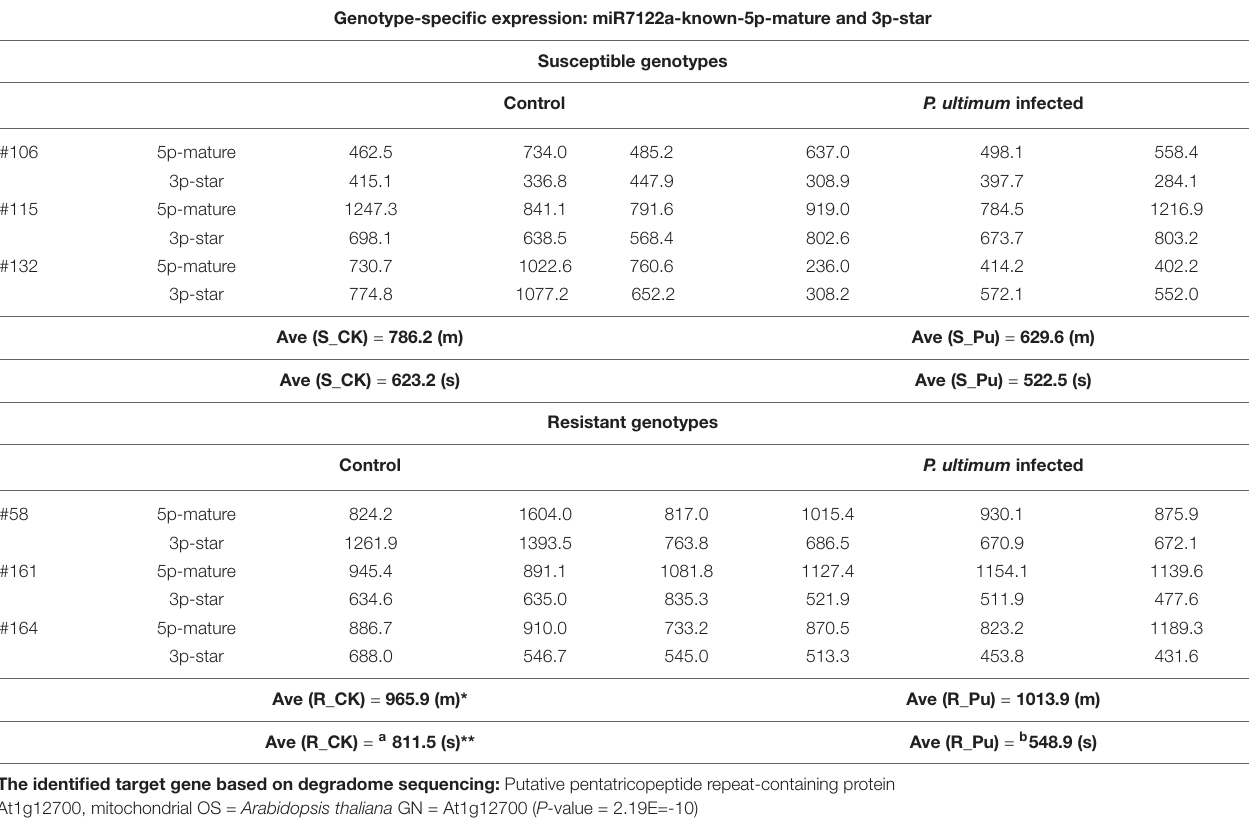
TABLE 8 | Genotype-specific expression of miR7122a-known-5p-mature, 3P-star, and identified target genes in apple roots in response to Pythium ultimum